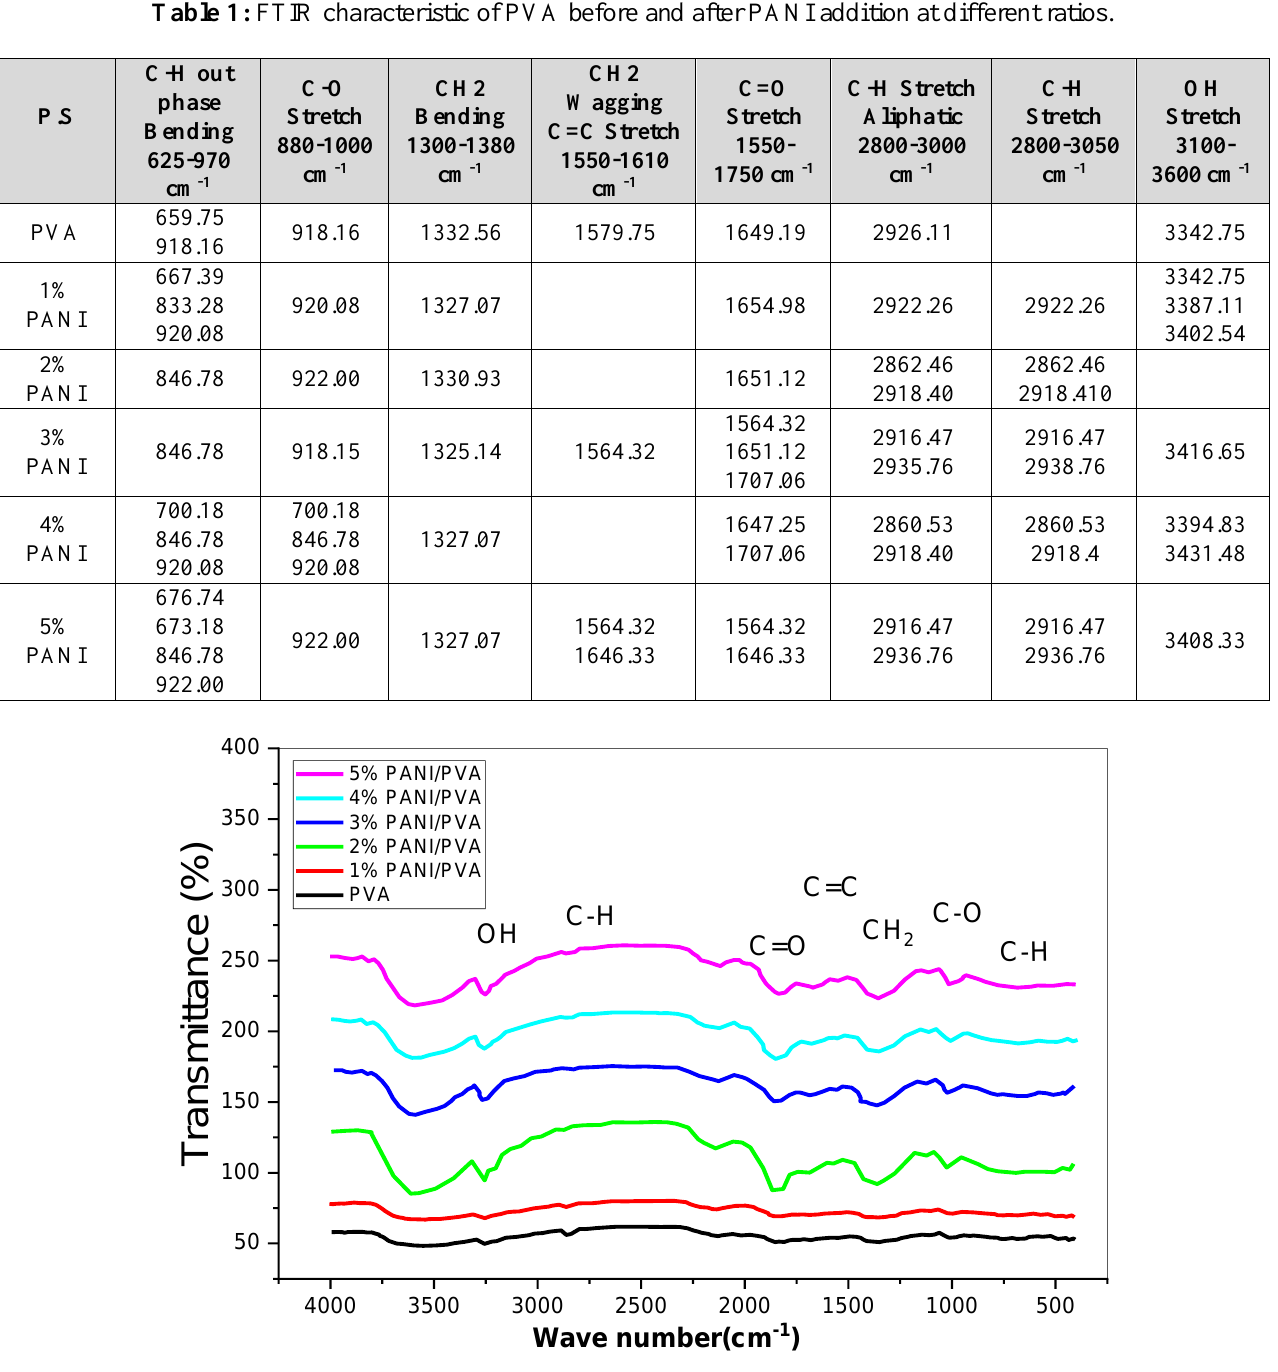
Figure 2: FTIR Spectra of PVA before and after PANI addition at different weight